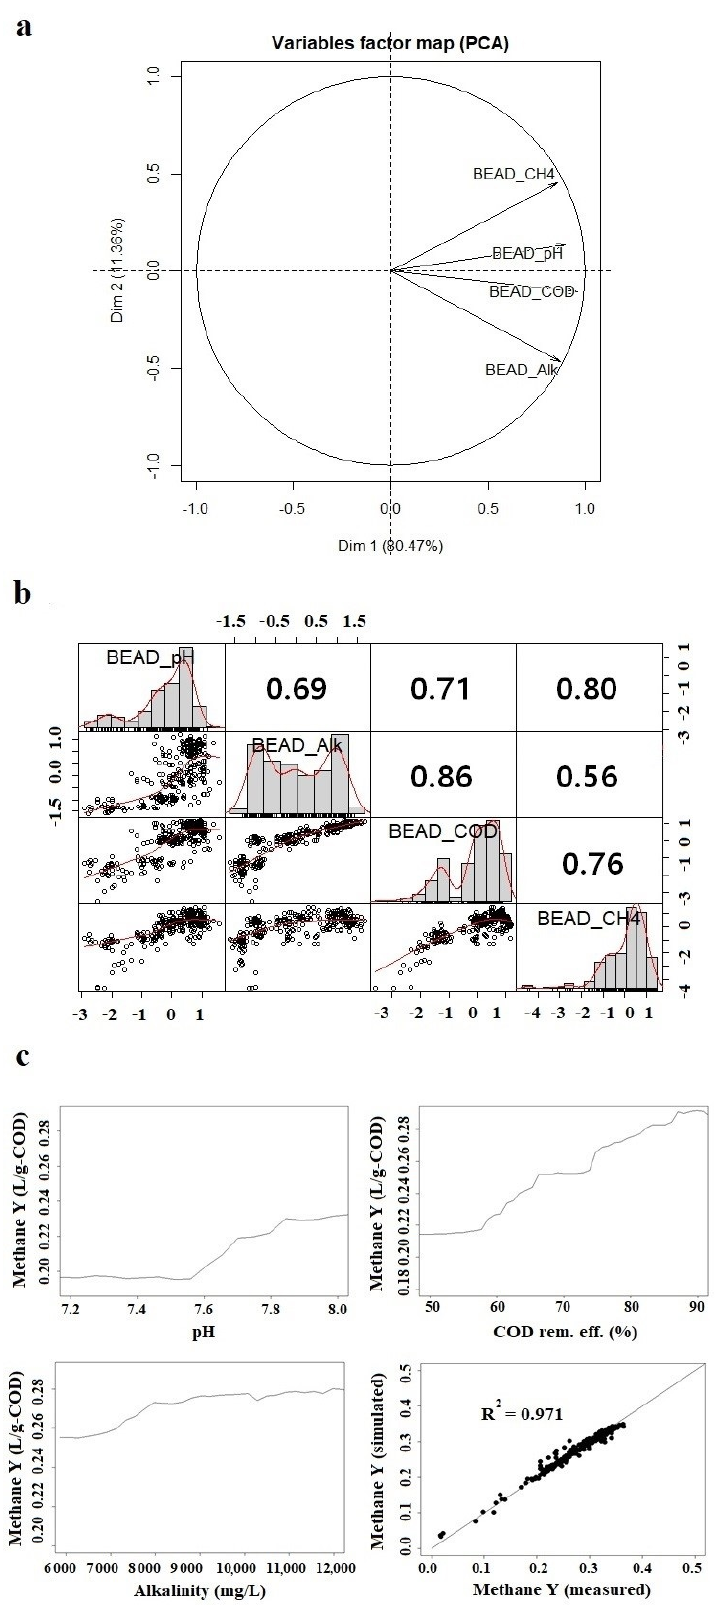
Figure 3. ( a ) Principal component analysis (PCA) loading plots and ( b ) scatter plots matrix for pair- wise correlations, and ( c ) partial dependents correlations between independent variables (pH, alkalin- ity, and COD removal efficiency) and subordination variable (methane yield) of bio-electrochemical anaerobic digestion